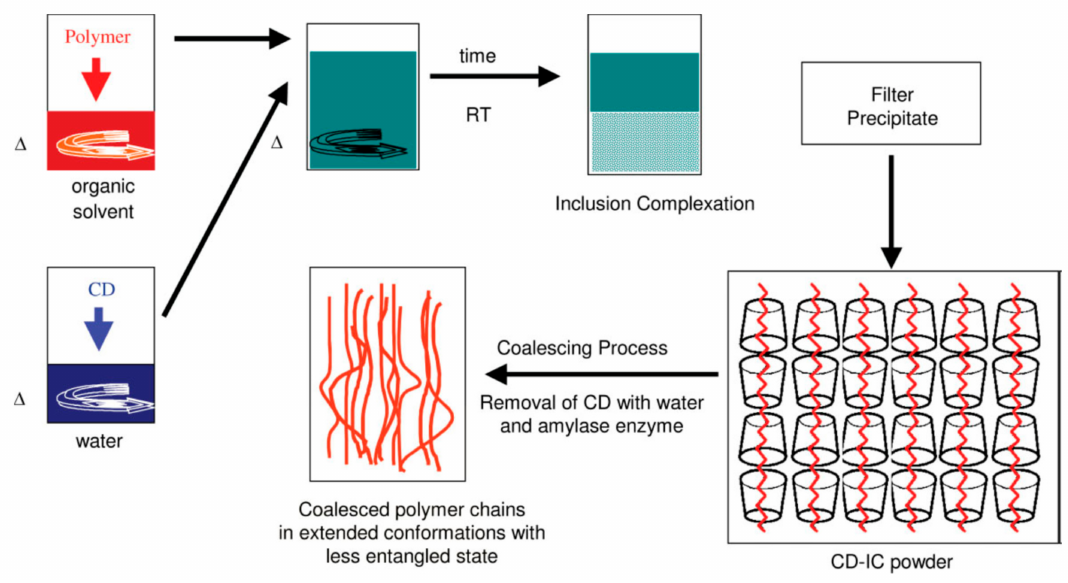
Figure 7. Schematic representation of polymer-CD IC formation, the coalescence process, and the bulk coalesced polymer. Reproduced with permission from [27]. Copyright 2005 Elsevier